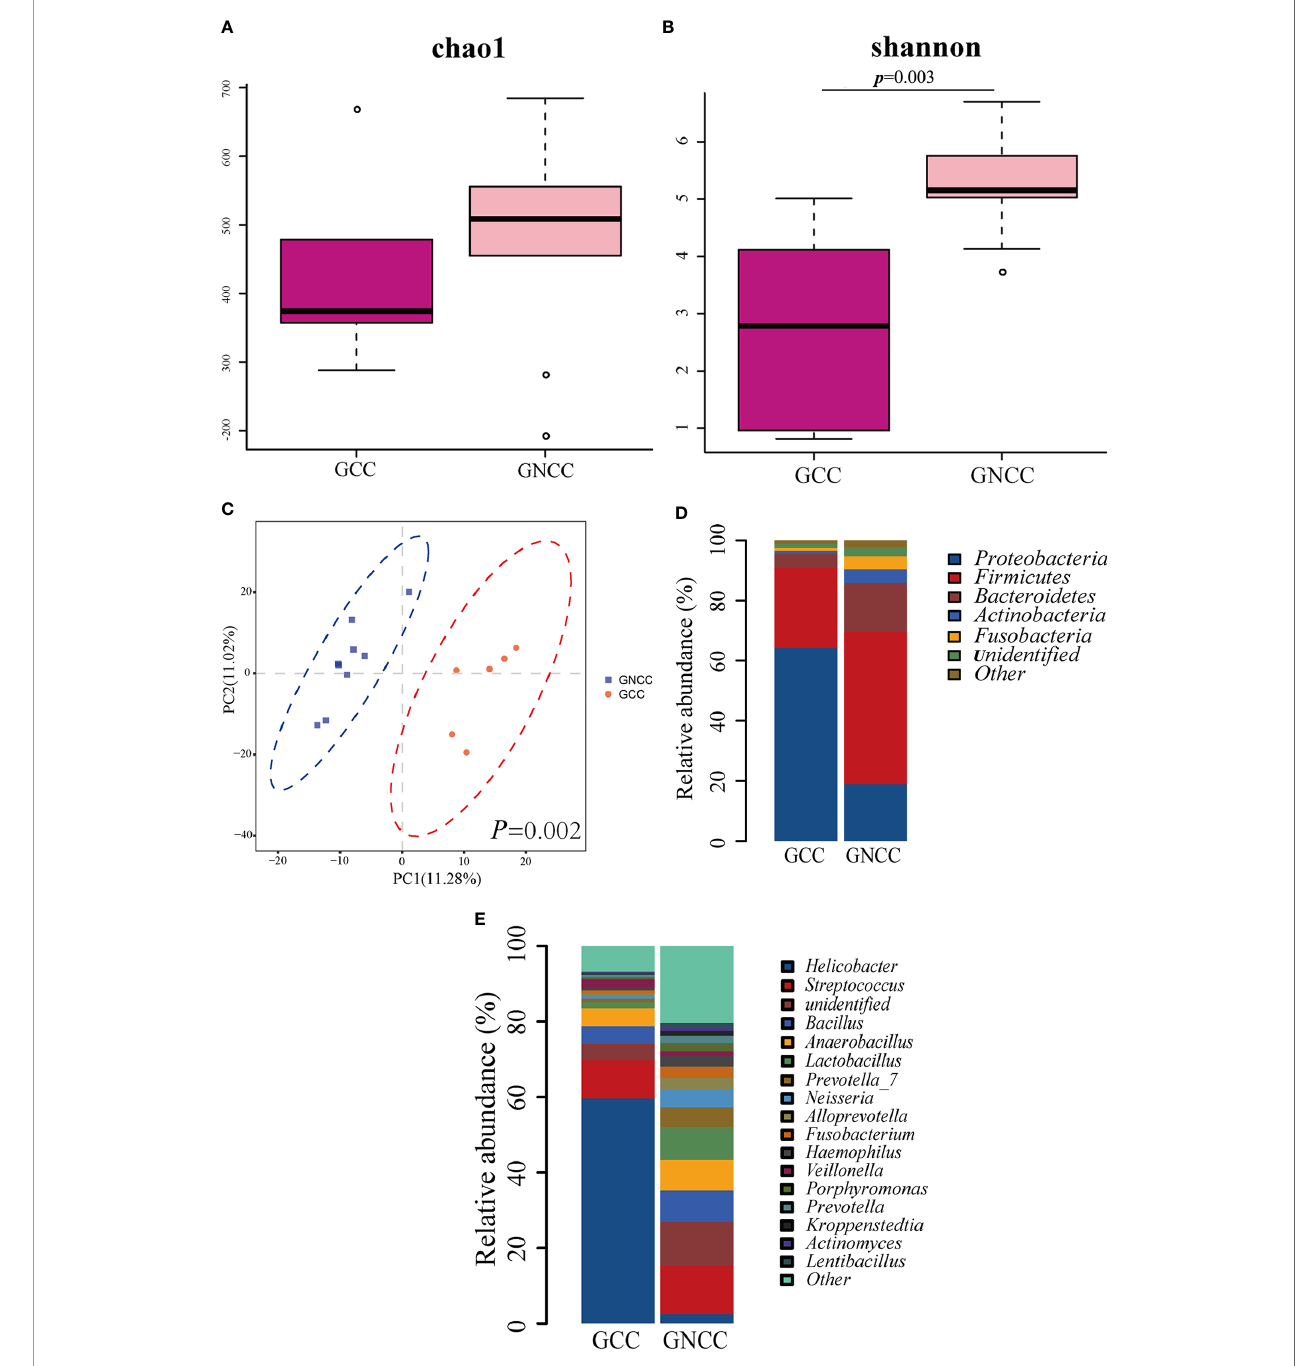
FIGURE 4 | The different gastric microbiota pro fi le between cardia cancer and non-cardia cancer. (A) There was no signi fi cant difference in Chao1 index between gastric cardia cancer (GCC) and gastric non-cardia cancer (GNCC) groups. (B) Shannon index was higher in GNCC group compared with GCC group (Student ’ s t-test was used to compare the two groups). (C) Partial least squares Discriminant Analysis (PLS-DA) revealed different microbial community structures between the two groups (ANOSIM was used to evaluate the similarity between groups). (D) Relative abundance of phyla in the two groups. (E) Relative abundance of genera in the two